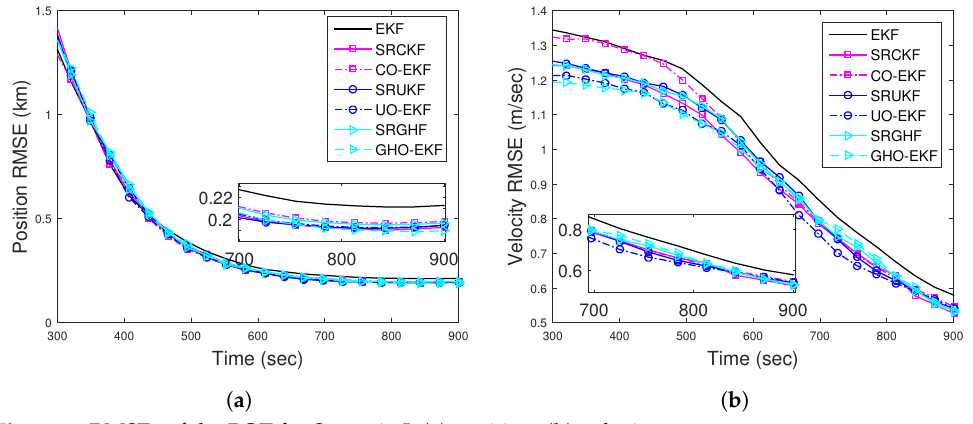
Figure 2. RMSEs of the BOT for Scenario I: ( a ) position; ( b )